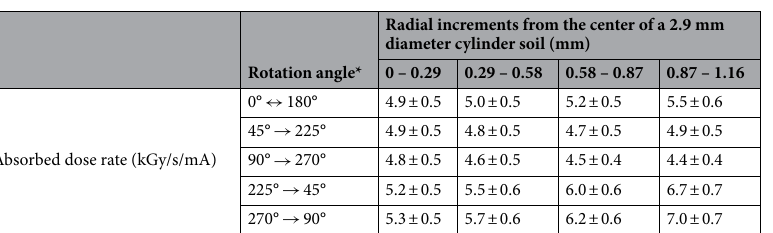
Table 2. Modeled absorbed dose rates for incremental soil cylinders at varying radial distances from the center at 0 mm and for varying rotation angles, using the MOGNO-A configuration with a 2.45 mm Si filter as illustrated in Figs. 2d and 5c. *Clockwise